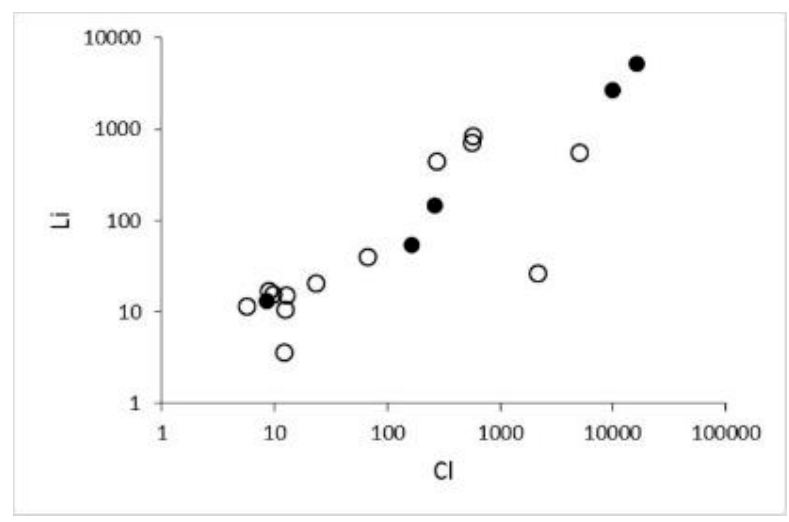
/ L) vs. Li ( µ g / L) correlation diagram. Symbols as in Figure Figure 12. Cl (mg/L) vs. Li ( μ g/L) correlation diagram. Symbols as in Figure 9. Figure 12. Cl (mg